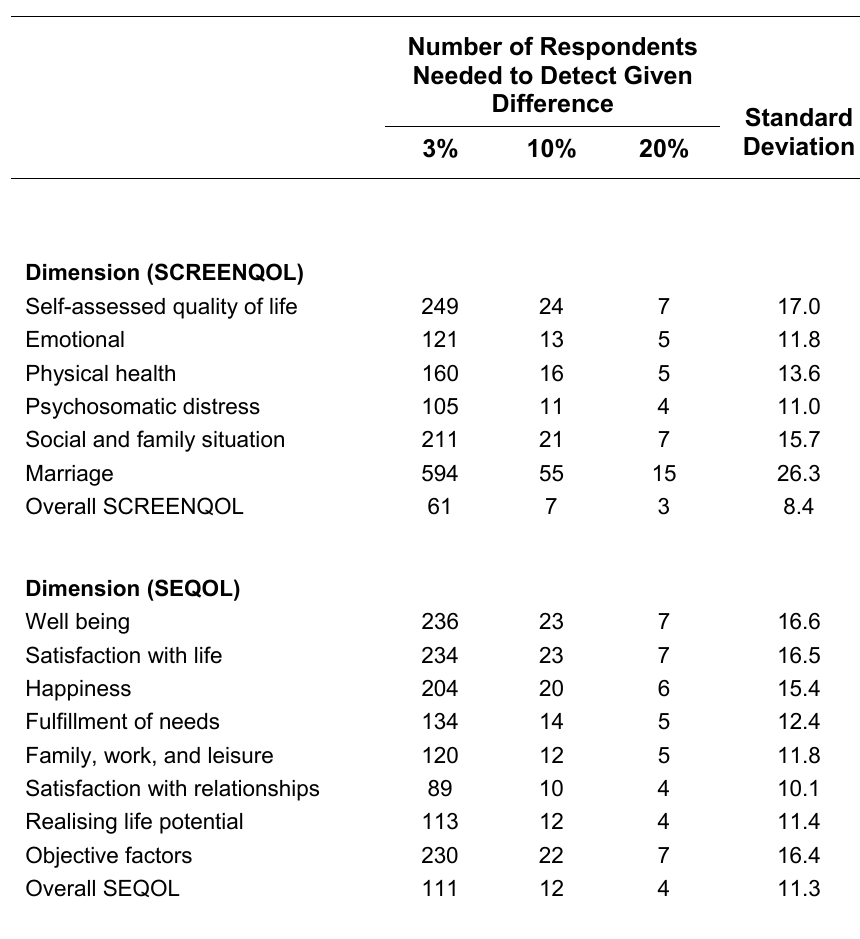
Sensitivity for SEQOL and